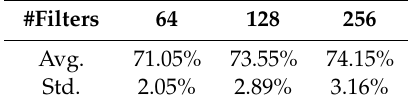
Table 6. Test accuracy using di ff erent filter numbers in the 1d network.